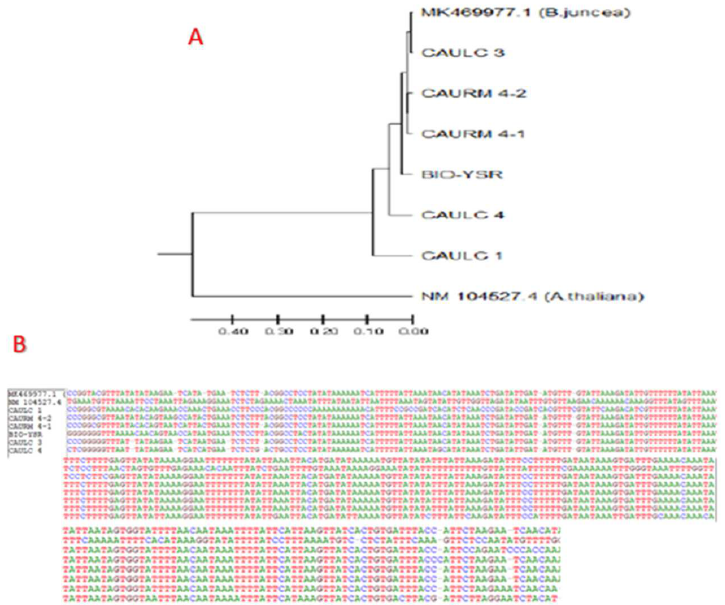
Figure 5. ( A ) UPGMA phylogenetic tree generated from MEGA Software. ( B ) Multiple sequence alignment of white rust resistance gene sequence belonging to B. juncea and Arabidopsis thaliana.